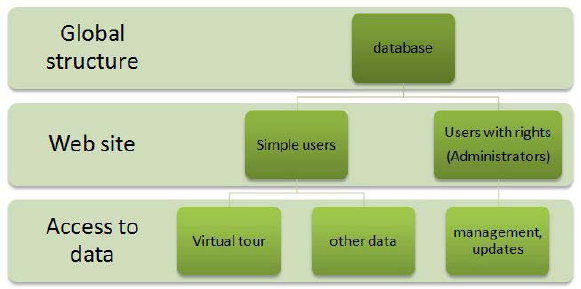
Figure 11. Global architecture of information